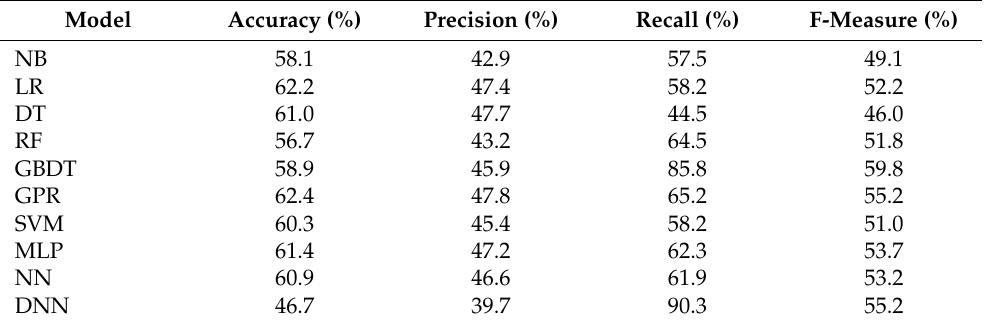
Table 14. Comparison of results of machine learning models based on analysis of outdoor thermal